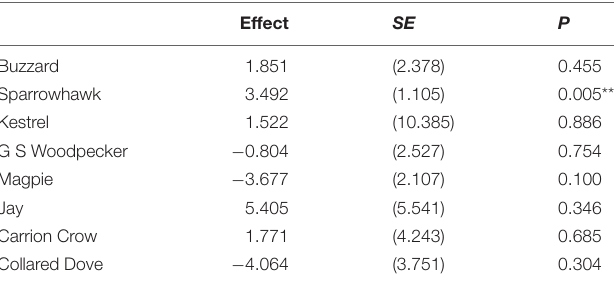
TABLE 4 | Regression of log e actual prey population change against log e prey population change predicted from significant predator effects, given mean change in predator abundance.